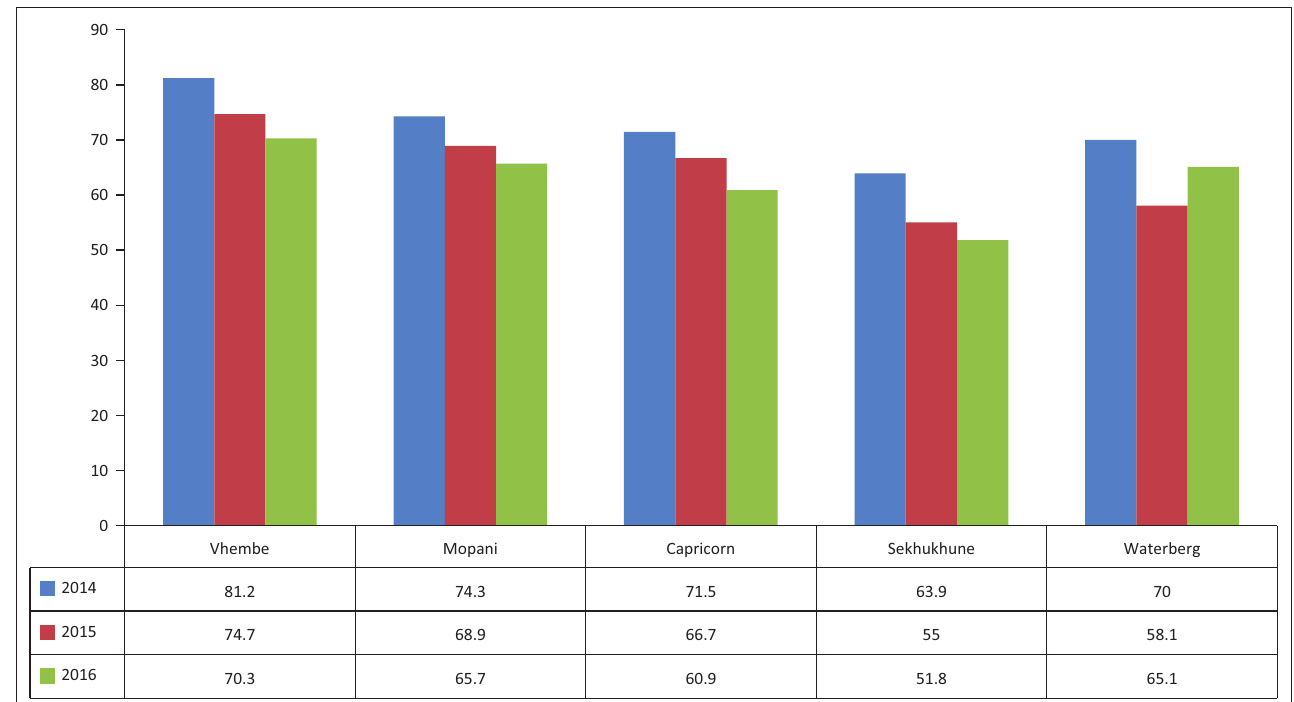
FIGURE 4: Districts performance in Limpopo Province, 3-year